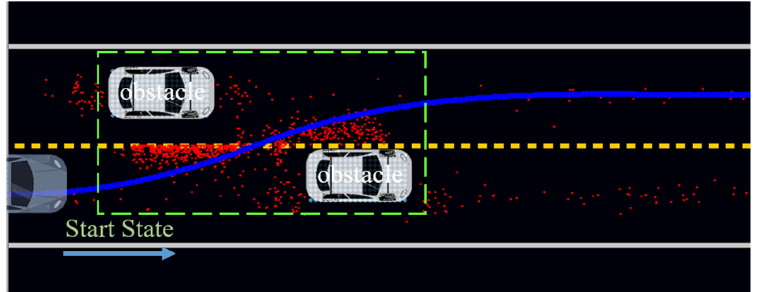
Figure 9. The combined CR-Map and Gaussian distribution sampling. After introducing the sampling method, the node optimization strategy of the